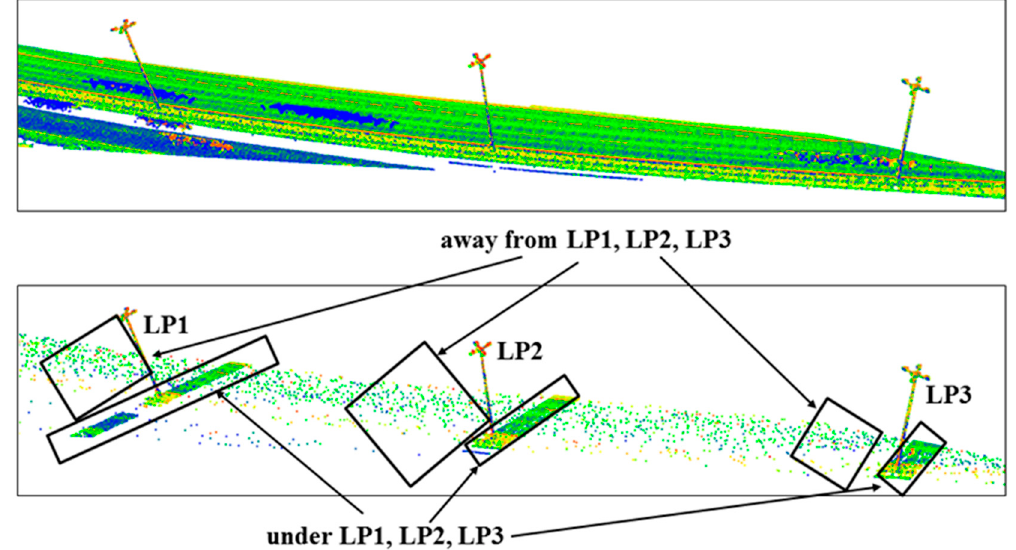
Figure 5. Effect of the Opt data reduction on an area containing LPs: original point cloud (top) and that sub-sampled by means of OptD at 1% of its original size (bottom).